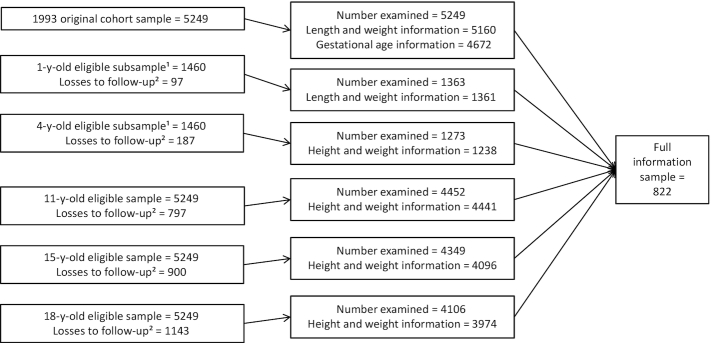
Participant flowchart. Inclusion criteria: participants who had information for weight, length/height, and gestational age. 1Follow-up visits including all birth weights <2500 g and a 20% sample of the remaining children. 2Includes subjects who either moved out of the study area, could not be located after several attempts, or refused to participate (the latter category included <4% of the sample).